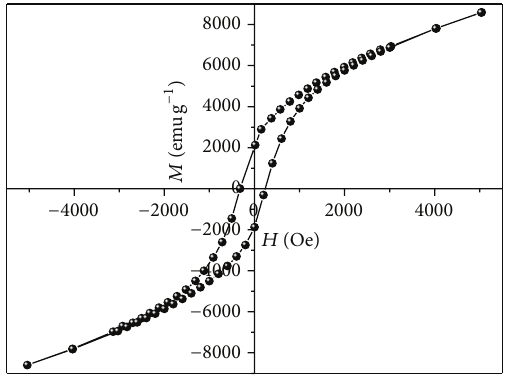
Figure 14: The hysteresis loop for the